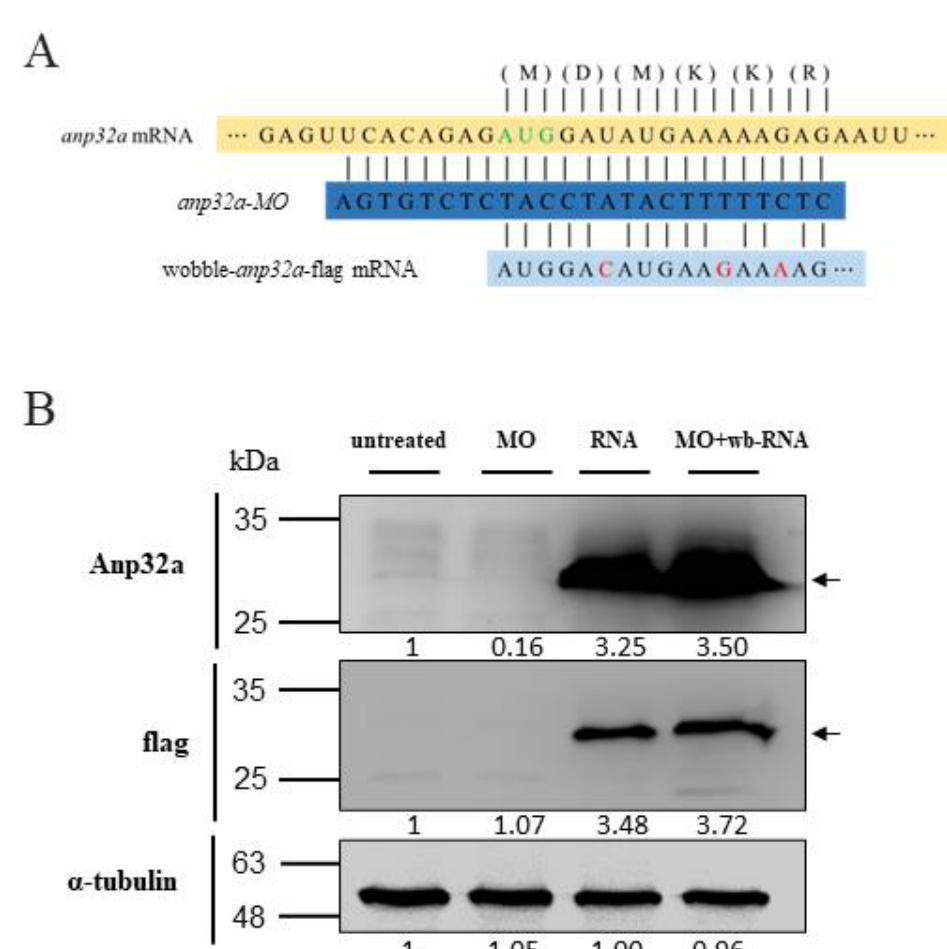
Figure 2. Western blot analysis of Anp32a in zebrafish embryos undergoing either knockdown or overexpression of Anp32a . ( A ) Diagrams were used to depict base-pairings among Anp32a mRNA, antisense morpholino oligonucleotides (MO) of Anp32a ( Anp32a -MO) and wobble nucleotides of Anp32a -flag mRNA (wobble- Anp32a -flag mRNA). ( B ) Western blot analysis. Zebrafish embryos at one-cell stage were microinjected with Anp32a -MO (MO), wobble- Anp32a- flag mRNA (wb-RNA) and MO plus wobble mRNA (MO + wb-RNA) as indicated, followed by extraction of total embryonic proteins at 48 hpf. Protein levels of endogenous Anp32a and exogenous Anp32a-flag were detected using antibodies against Anp32a and reporter protein flag. α -tubulin served as an internal control. Protein levels relative to each internal control are presented below each lane.